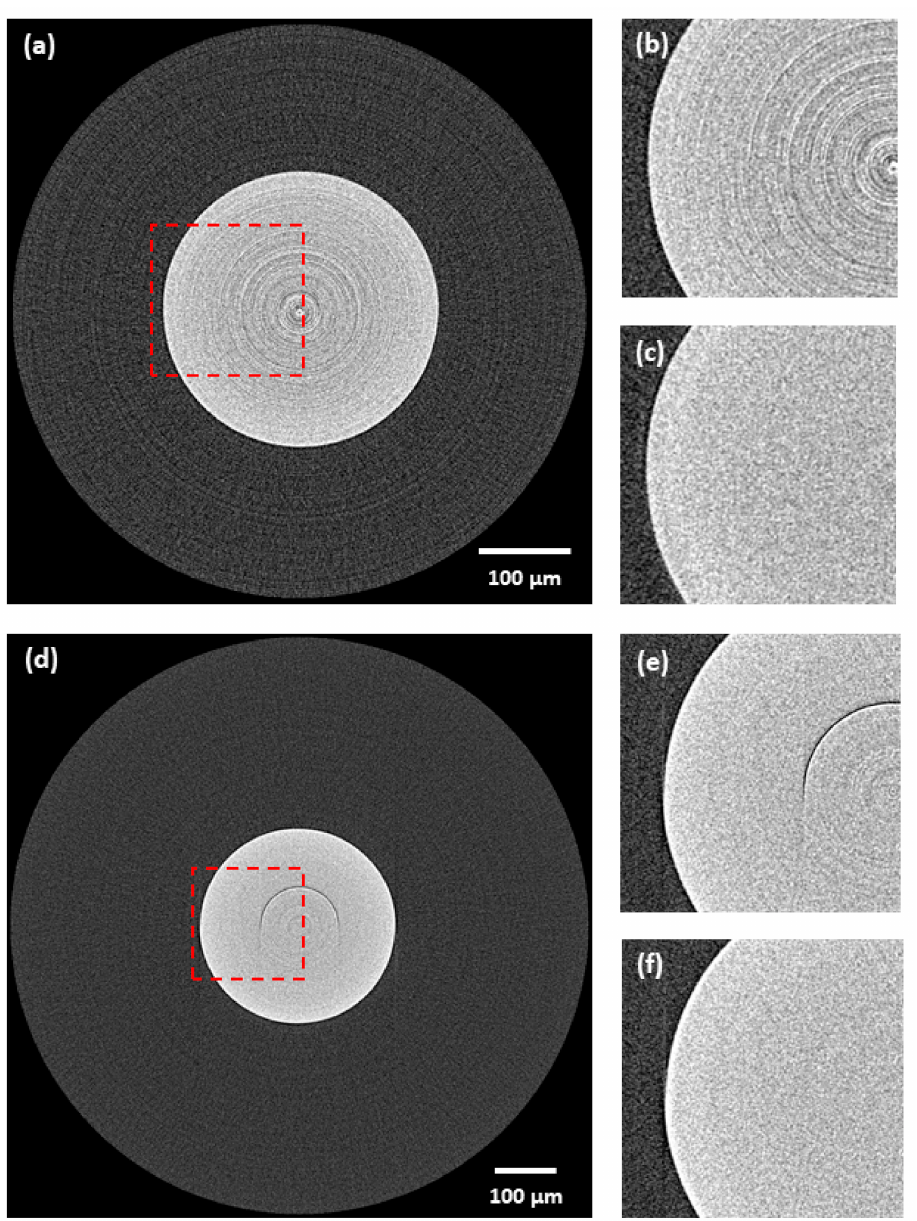
Figure 12. Demonstration of robustness of the proposed method to the used detection system—real CT data of ruby ball: ( a ) original tomogram (scientific complementary metal-oxide-semiconductor (sCMOS), without any correction)—red labelled area marks the central area visualized in following images; ( b ) detail (sCMOS)—original; ( c ) detail (sCMOS)—corrected by proposed method; ( d ) original tomogram (CCD, without any correction)—red labelled area marks the central area visualized in following images; ( e ) detail (CCD)—original; ( f ) detail (CCD)—corrected by proposed method. For visualization, the same contrast setting was used for all the